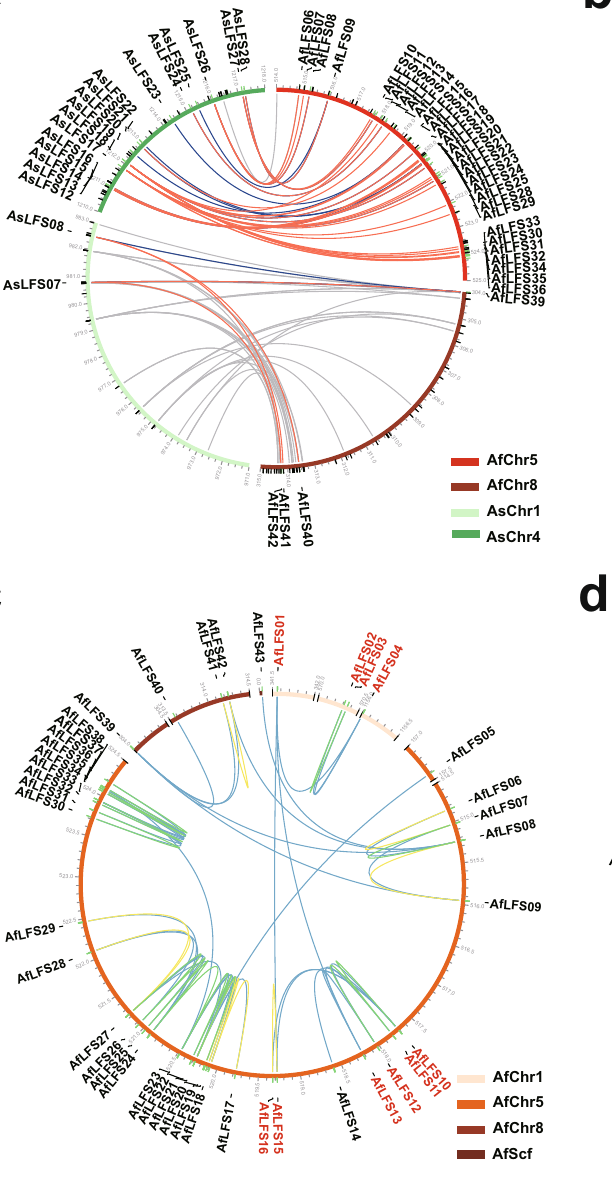
duplication relationships of LFS ( c ) and ALL ( d ) in A. fi stulosum . The blue line indicates dispersed duplication relationship, the green line indicates tandem duplication relationship, and the yellow line indicates proximal duplication rela- tionship. The gene details are listed in Supplementary Data 1 –